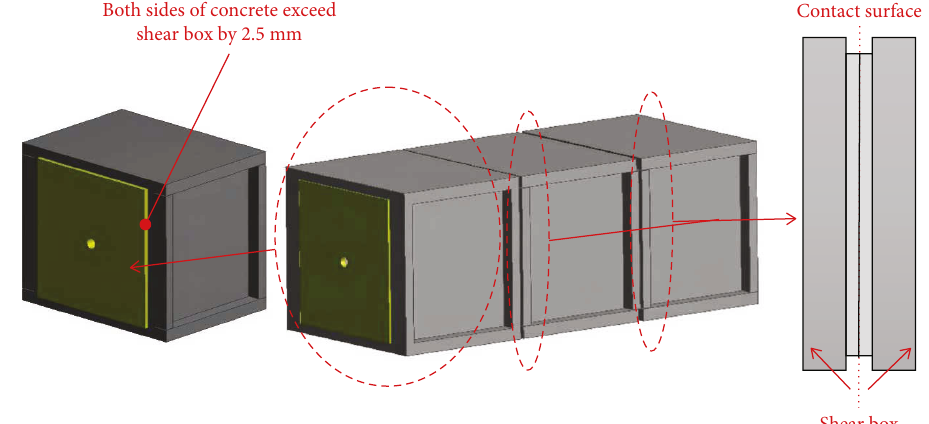
Figure 2: Schematic diagram of shear box structure.